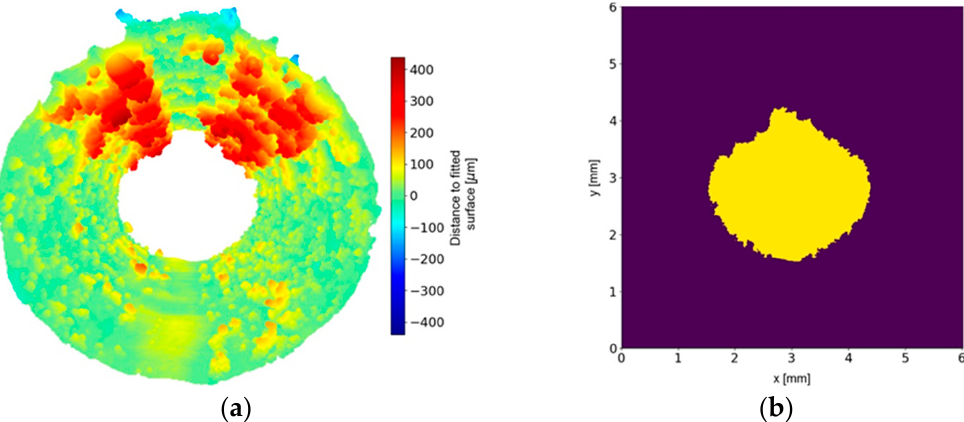
Figure 7. Equivalent diameter of D nom = 3 mm. ( a ) Through view of 3D visualization; ( b ) through view of stacked cross-sectional images.